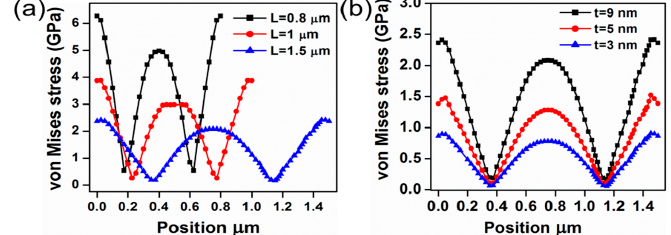
Figure 4. The von Mises stress of double-clamped graphene beam NEM switches. ( a ) von Mises stress of graphene NEM switches A, B, and C; ( b ) von Mises stress of graphene beam NEM switch A, with different graphene thicknesses of t = 3, 5, and 9 nm.